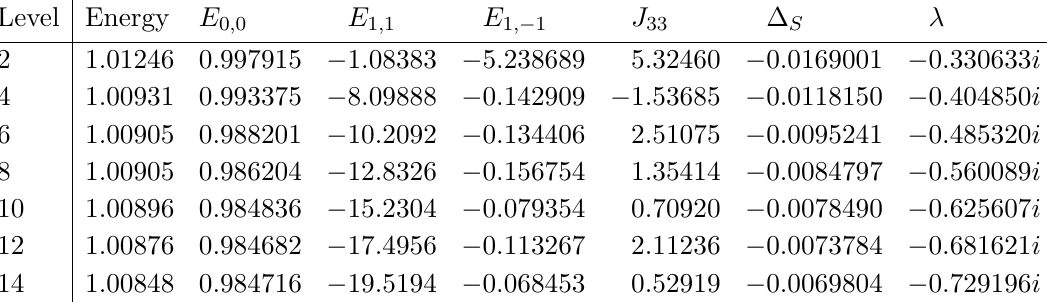
Table 16 . Independent observables and the marginal parameter λ of the special complex marginal solution in the k = 2 model with J = 1 boundary conditions. We show only even level data because 2 of the odd level instability.